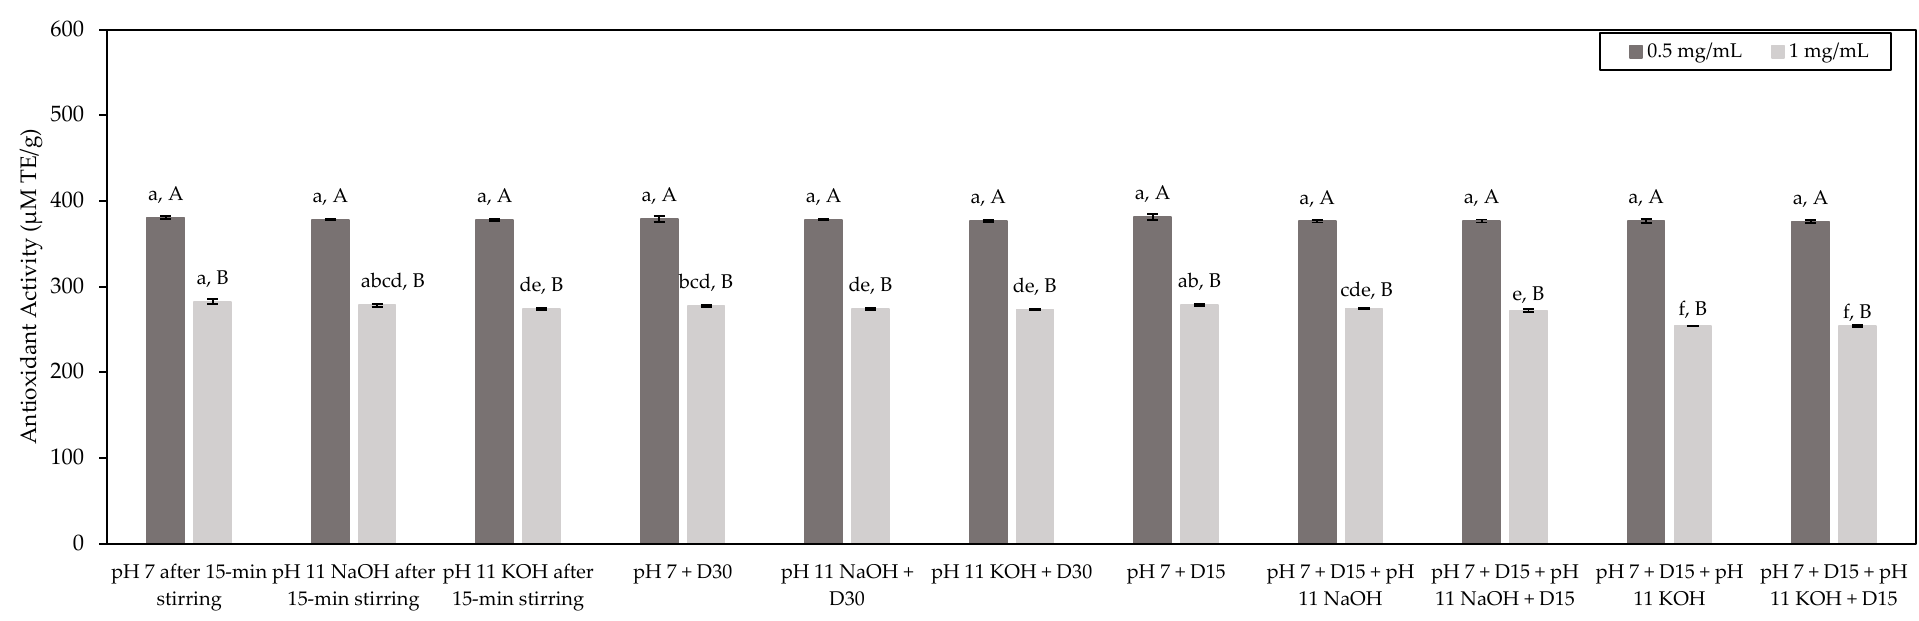
Figure 4. Antioxidant activity of the HMH solutions corresponding to the different tested conditions and determined by the DPPH test (mean ± standard deviation) expressed in µmol TE/g. Values with different lowercase letters (a–f) within the same concentration are significantly different p < 0.05 (Tukey test); values with different uppercase letters (A,B) within the same condition are significantly different p < 0.05 ( t -test).